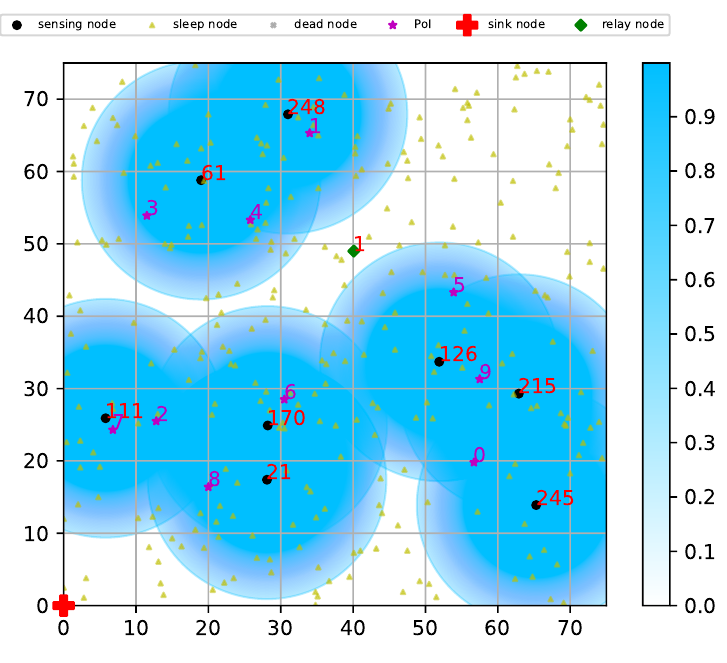
Figure 5. Depiction of a network at a